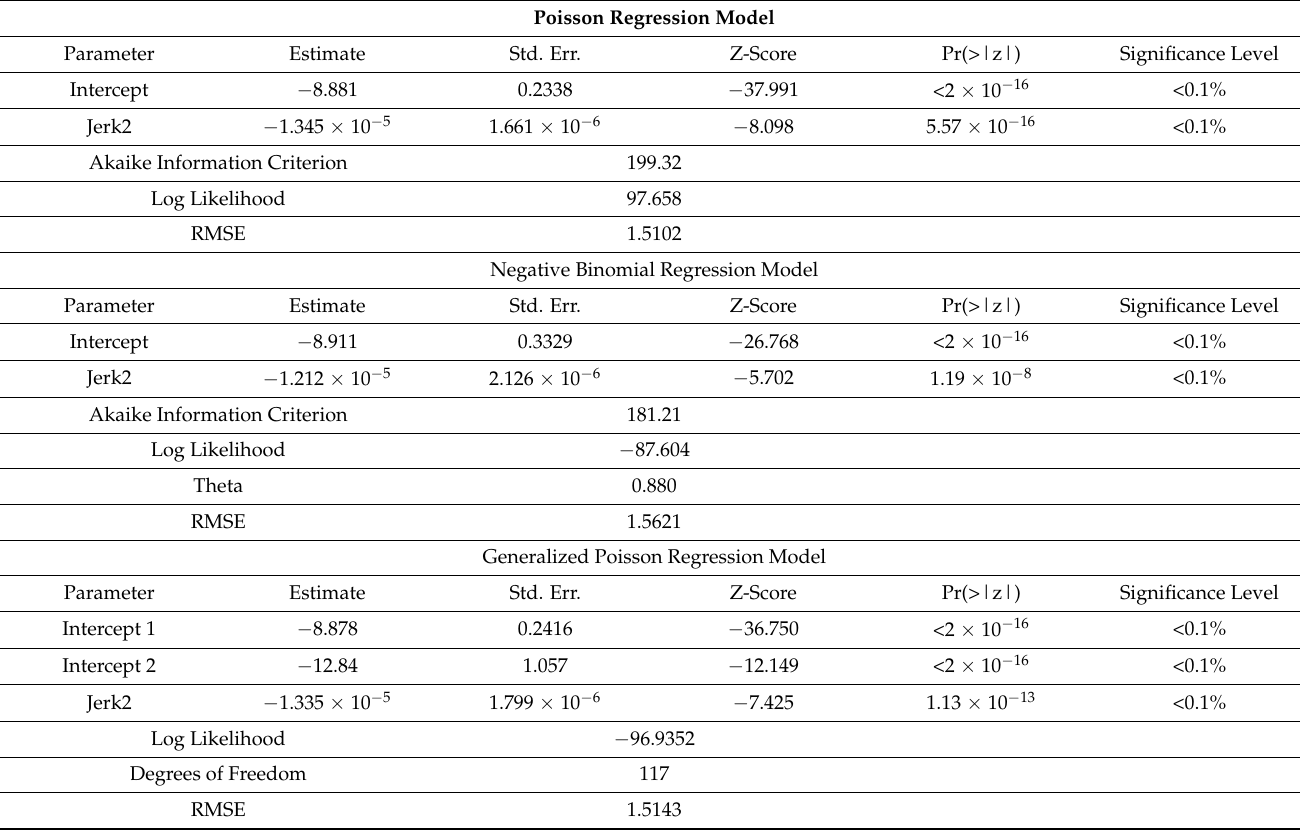
Table 4. Summary of regression models for segment analysis. Poisson Regression